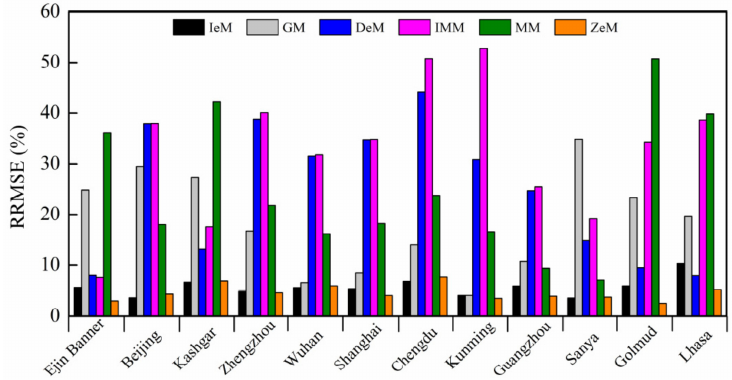
Figure 3. RRMSE values for the six models at 12 selected stations.